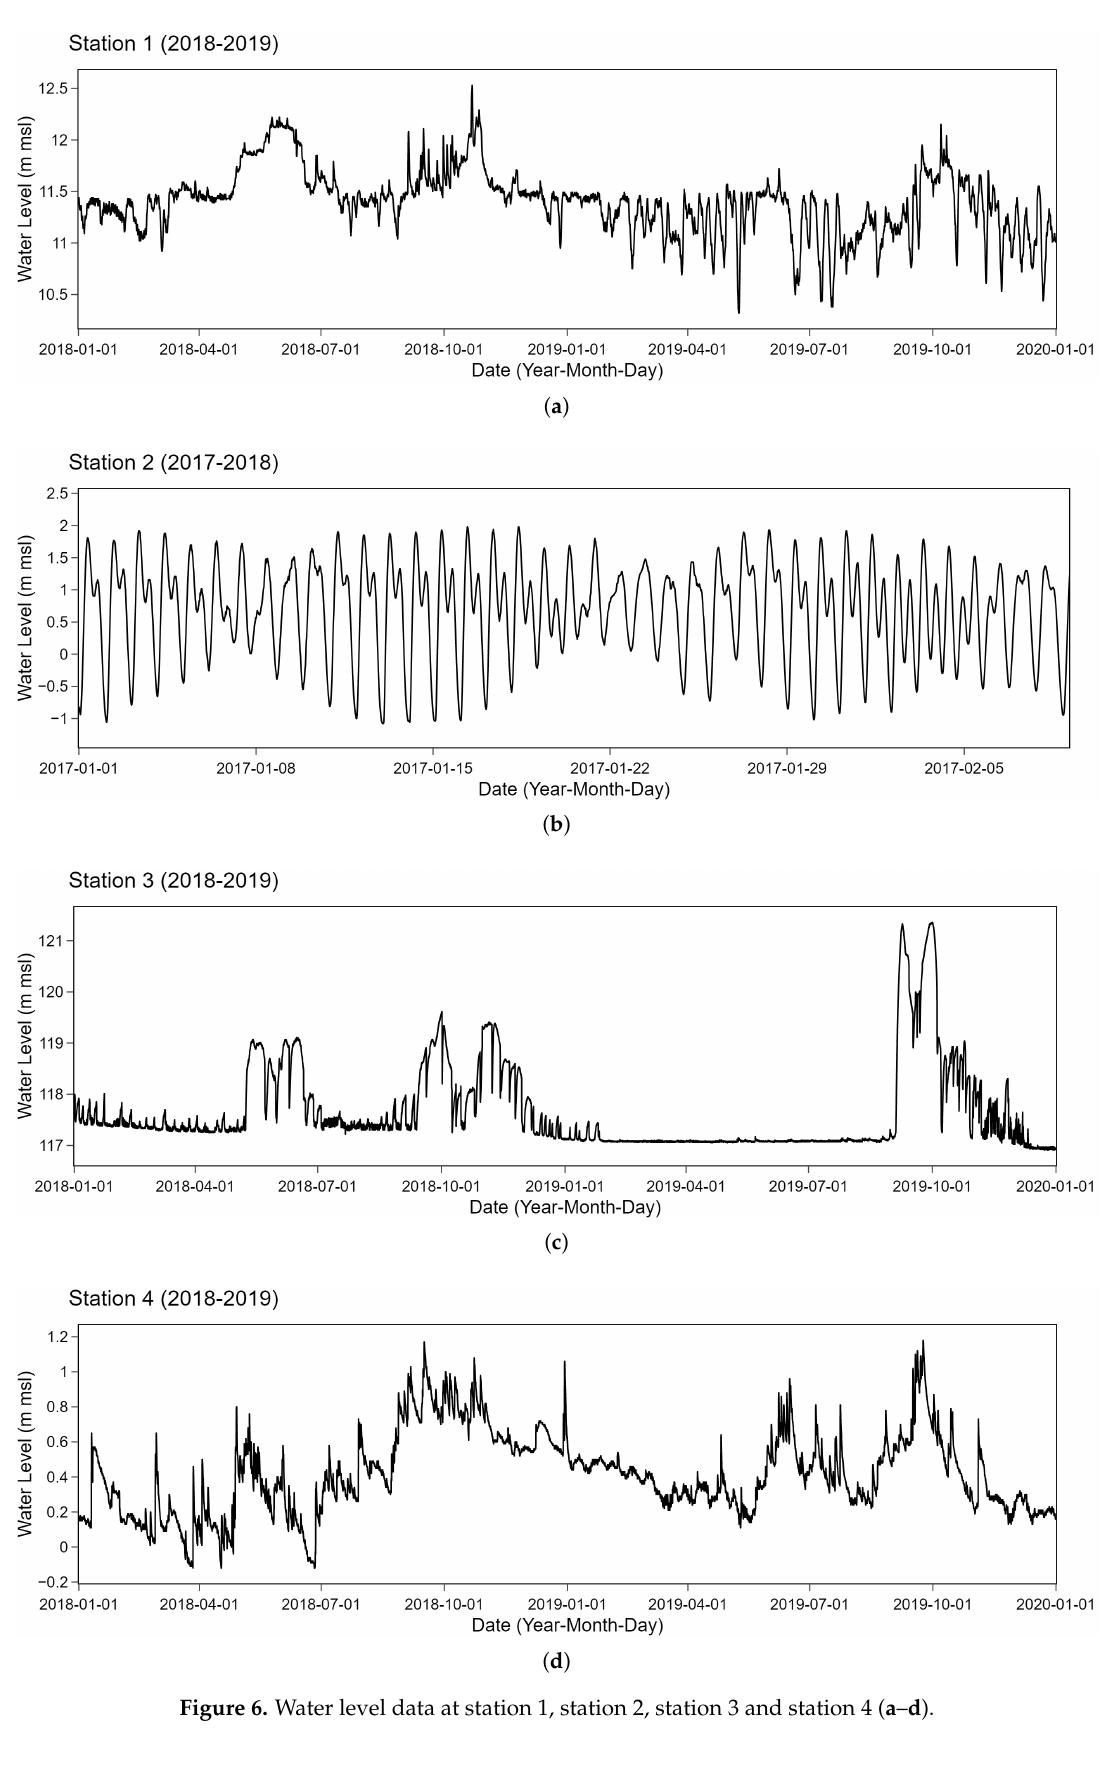
Figure 6. Water level data at station 1, station 2, station 3 and station 4 ( a – d